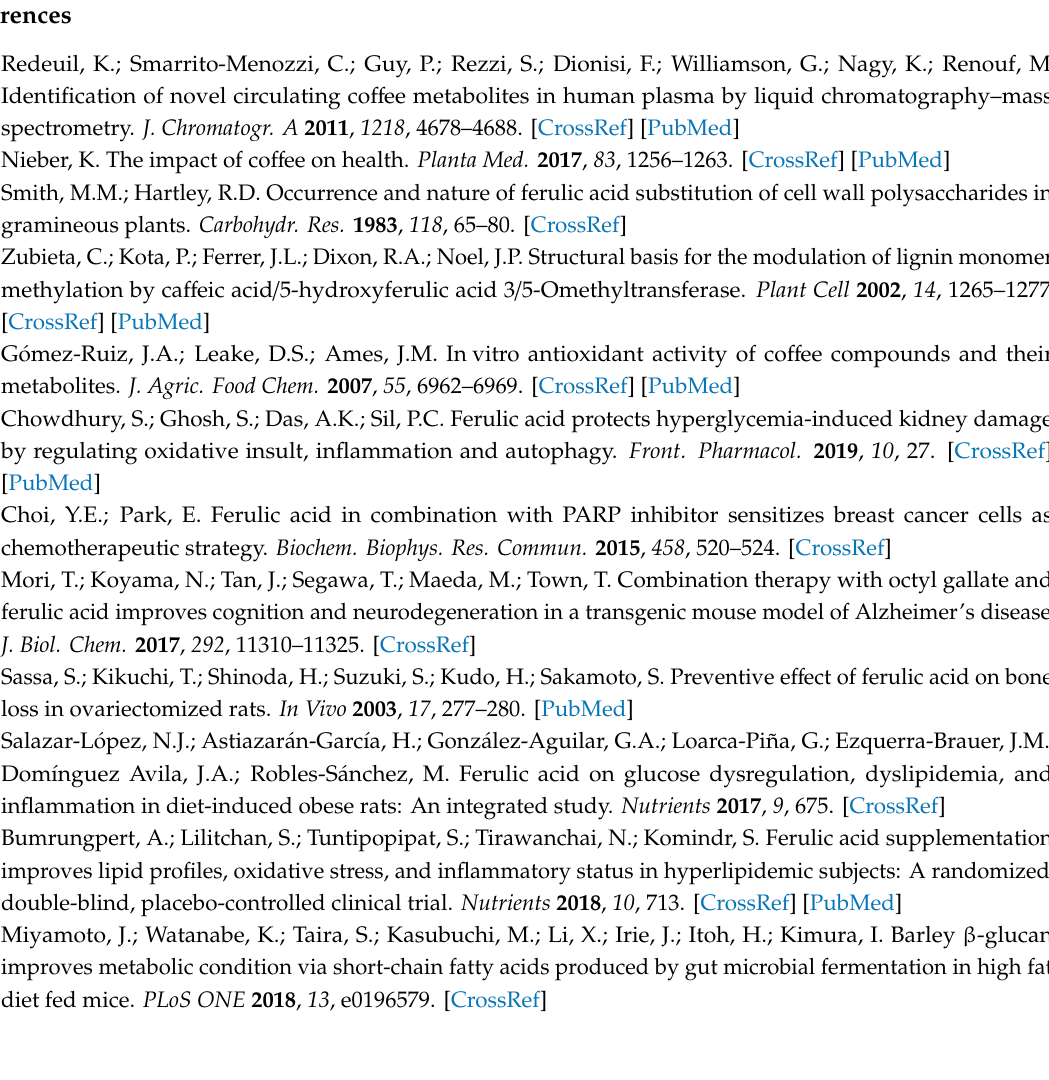
Figure S1: Metabolic parameters in HFD-fed and HMCA-supplemented HFD-fed mice, Figure S2: Plasma pharmacokinetic profiles of HMCA and HMPA after intraperitoneal injection in conventional mice, Figure S3: Metabolic parameters in HFD control and HMPA-supplemented HFD-fed mice. Table S1: Daily calorie intake in HMCA consumption, Table S2: Daily calorie intake in HMPA